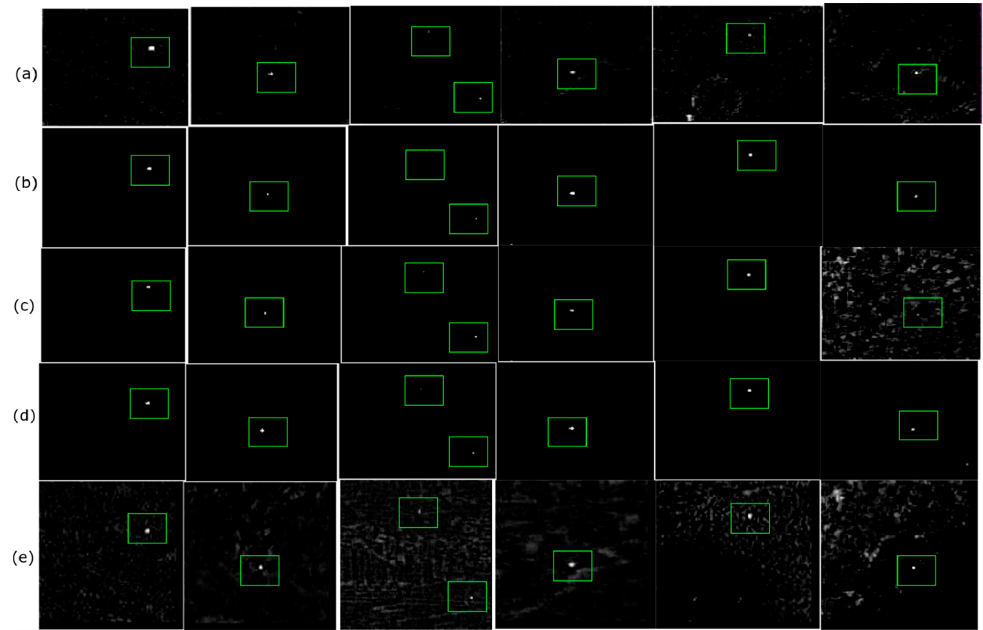
Figure 6. The target detection performance of the various methods on the image sequences presented in rows ( a – e ): ( a ) RPCA; ( b ) NIPPS; ( c ) RIPT; ( d ) IPCWLP–RPCA; ( e ) our method.